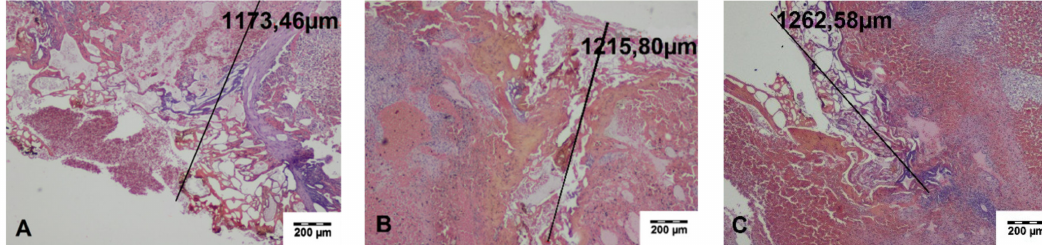
Figure 3. Histopathological sections of the spleen fragments collected intraoperatively, showing changes produced by the thulium-doped fiber laser (TDFL). Black lines indicate the width of the entire zone of thermal damage (hematoxylin and eosin (HE) staining). ( A ) A superficial zone of carbonization and a deeper zone of thermal changes are present in the spleen parenchyma (magnification × 40); ( B , C ) magnification × 100.